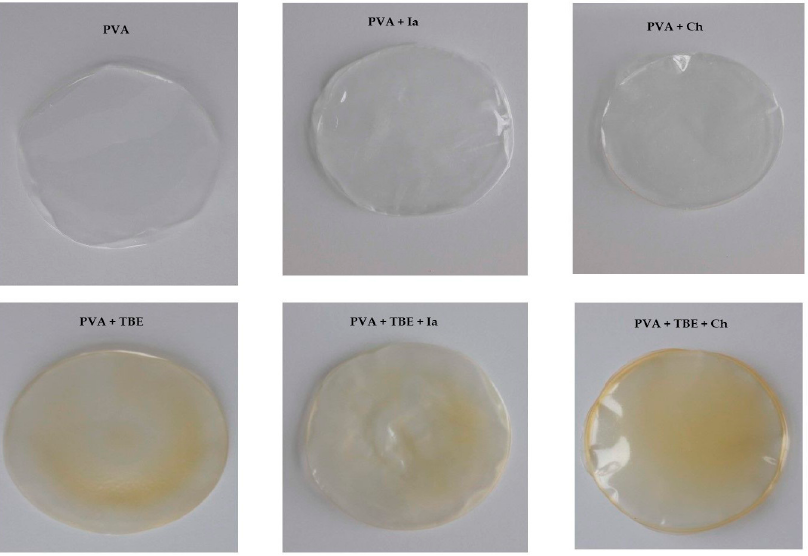
Figure 5. The physical appearance of the obtained films.